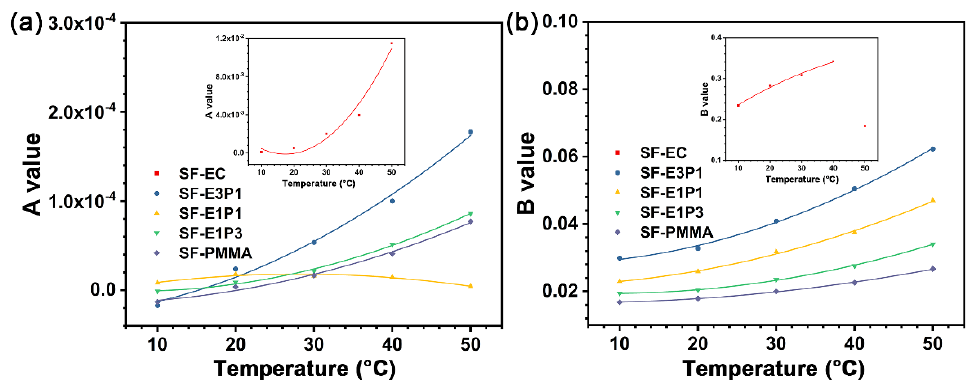
Figure 10. ( a ) A value and ( b ) B value fitted with a quadratic polynomial base varies with tempera- ture. The fitting formula is a quadratic polynomial, and R 2 > 0.95. Inset: A value ( a ) and B value ( b ) of SF-EC.